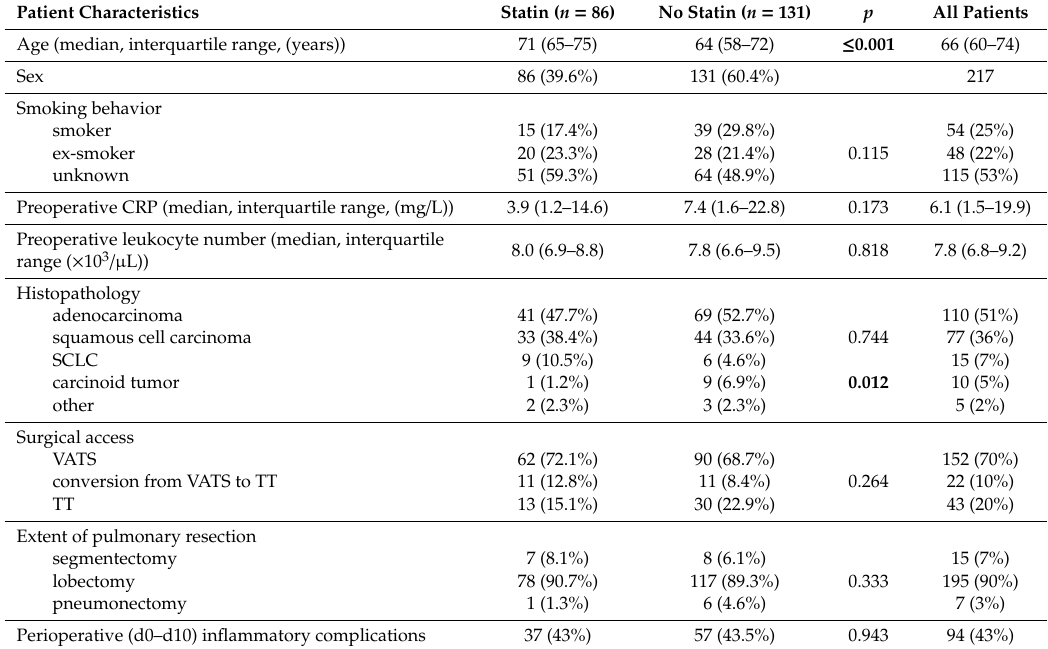
Table 4. Characteristics of patients ( n = 217) included in this study stratified according to statin